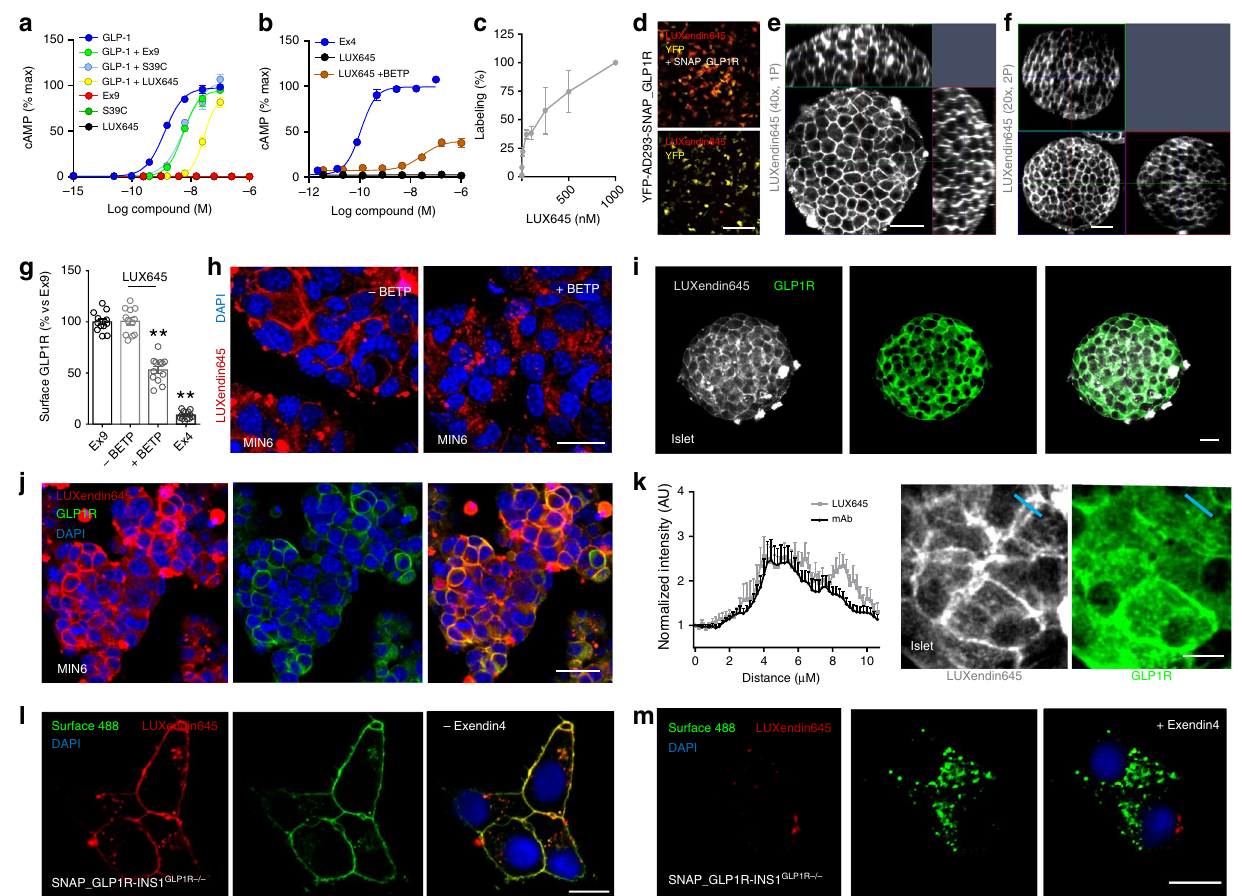
Fig. 2 LUXendin645 binding, signaling, and labeling. a Exendin4(9 – 39), S39C-Exendin4(9 – 39), and LUXendin645 (LUX645) display similar antagonistic properties (applied at 1 µ M) in HEK293-SNAP_GLP1R following 30 min GLP-1-stimulation ( n = 4 independent assays). b LUXendin645 weakly activates GLP1R in the presence of the positive allosteric modulator (PAM) BETP (25 µ M) (30 min stimulation in HEK293-SNAP_GLP1R) (Ex4, + ve control) ( n = 4 independent assays). c LUXendin645 labels AD293-SNAP_GLP1R cells with maximal labeling at 250 – 500 nM ( n = 4 independent assays). d LUXendin645 signal cannot be detected in YFP-AD293 cells (scale bar = 212.5 µ m) ( n = 3 independent assays). e Representative confocal z-stack showing LUXendin645 staining in a live islet ( n = 27 islets, six animals, three separate islet preparations) (scale bar = 37.5 µ m). f As for e , but two-photon z-stack (scale bar = 37.5 µ m) (representative image from n = 27 islets, seven animals, three separate islet preparations). g, h 250 nM LUXendin645 internalizes GLP1R in MIN6 β -cells when agonist activity is conferred using 25 µ M BETP (Ex4 and Ex9 were applied at 100 and 250 nM, respectively) (scale bar = 21 µ m) (representative images from n = 12 coverslips, three independent repeats) (one-way ANOVA with Bonferroni ’ s test; F = 217.6, DF = 3). i, j LUXendin645 signal co-localizes with a GLP1R monoclonal antibody in islets ( n = 13 islets, three separate islet preparations) and MIN6 β -cells (representative images from n = 24 coverslips, three independent repeats) (scale bar = 26 µ m). k LUXendin645 improves membrane visualization compared to antibody (scale bar = 12.5 µ m). Representative images are shown, with location of intensity-over-distance measures indicated in blue ( n = 18 islets, fi ve animals, three separate islet preparations). l, m LUXendin645 co-localizes with Surface 488, pre-applied to Glp1r null SNAP_hGLP1R- INS1 GLP1 − / − cells l . Pre-treatment with Exendin4(1 – 39) to internalize the GLP1R reduces LUXendin645 – labeling m (scale bar = 10 µ m) (representative images from n = 3 independent repeats). LUXendin645 was applied to cells at 250 nM and tissue at 50 – 100 nM. GLP-1 glucagon-like peptide-1; Ex9 Exendin4(9 – 39); S39C S39C-Exendin4(9 – 39); Ex4 Exendin4(1 – 39). Mean± s.e.m. are shown. ** P < 0.01 for all statistical tests. Source data are provided as a Source Data fi